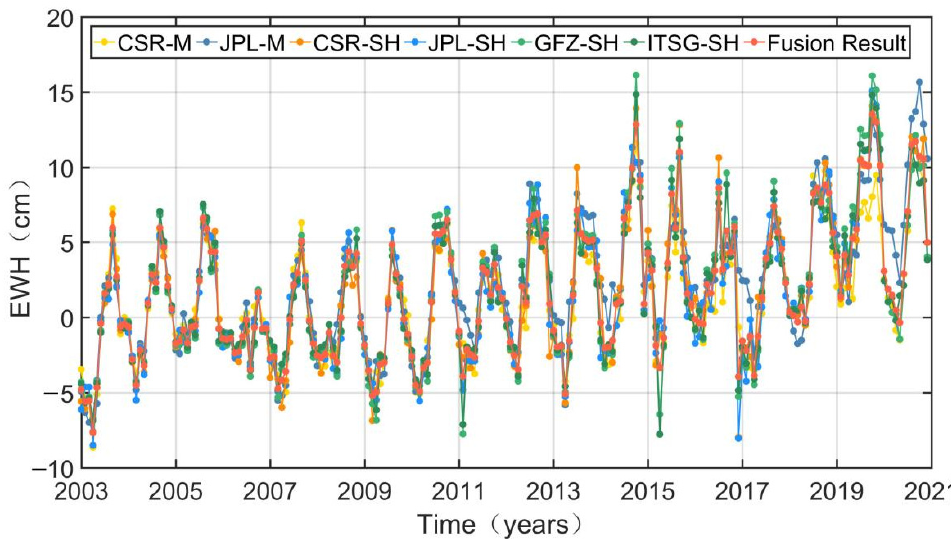
Figure 3. The spatial distribution of uncertainties of the TWSC results derived from the fused re- sults.